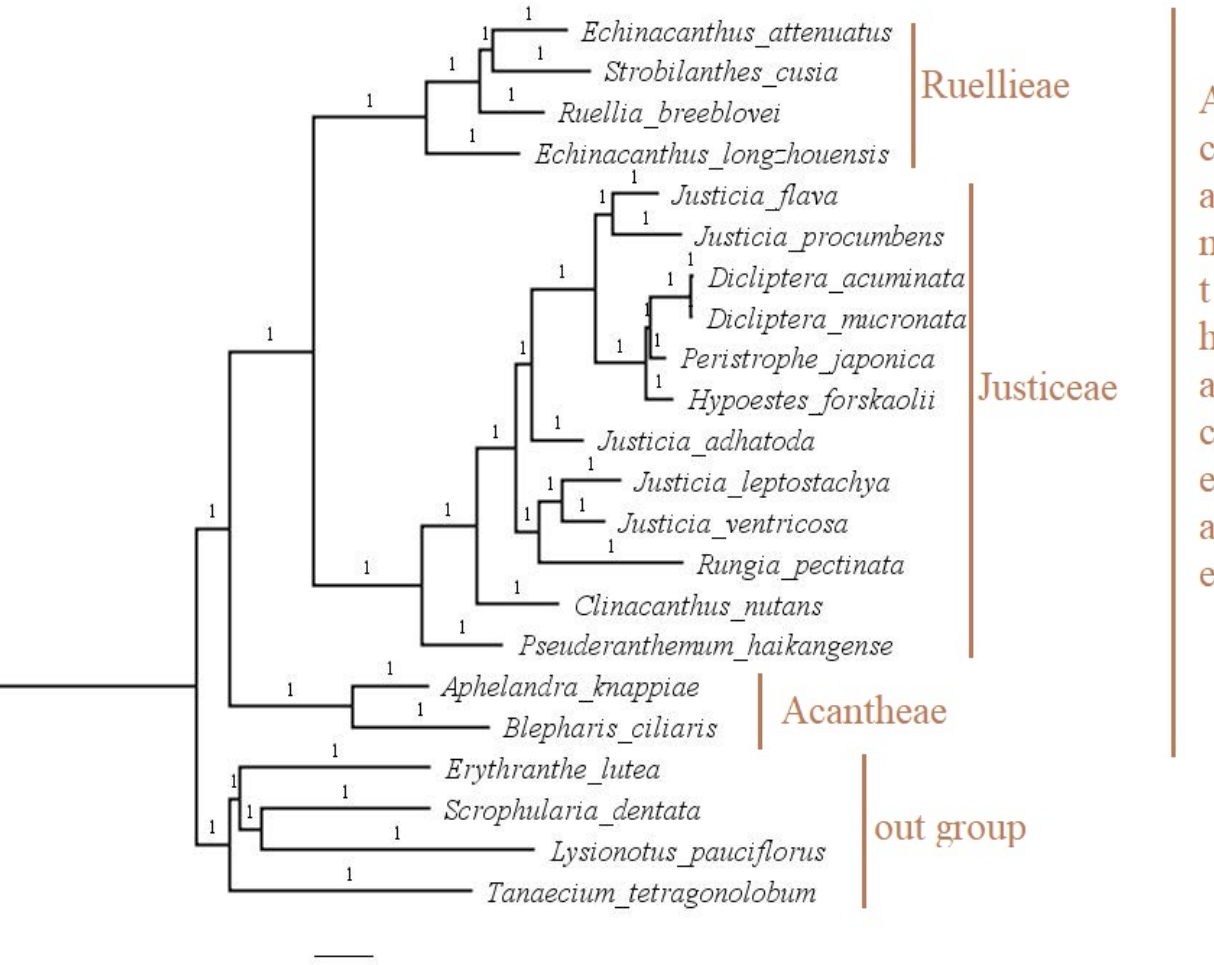
Figure 9. Bayesian inference phylogenetic tree reconstructed using the cp genome of 22 taxa. The branch nodes ’ numbers represent the posterior probabilities values (PP).